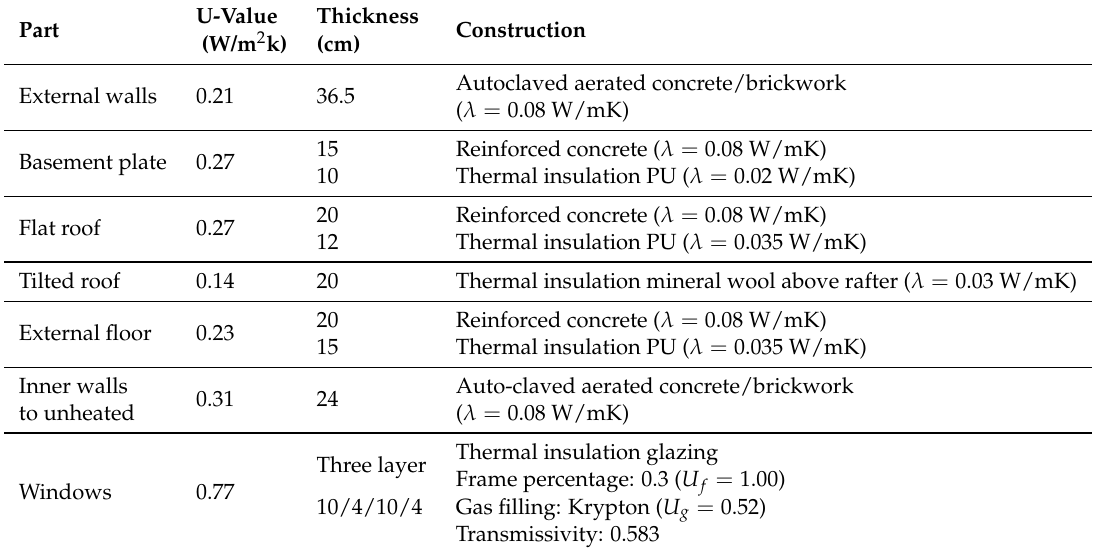
Table 2. Building construction